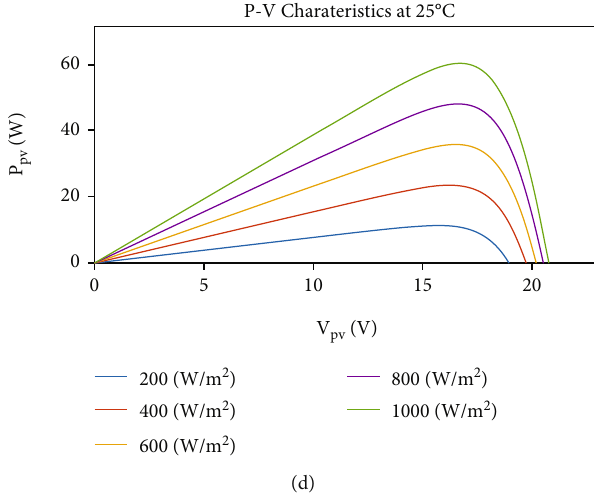
Figure 4: Current-voltage (a) and power-voltage characteristics (b) (case of constant irradiance and variable temperature) and current- voltage (c) and power-voltage characteristics (d) (case of variable irradiance and constant temperature).